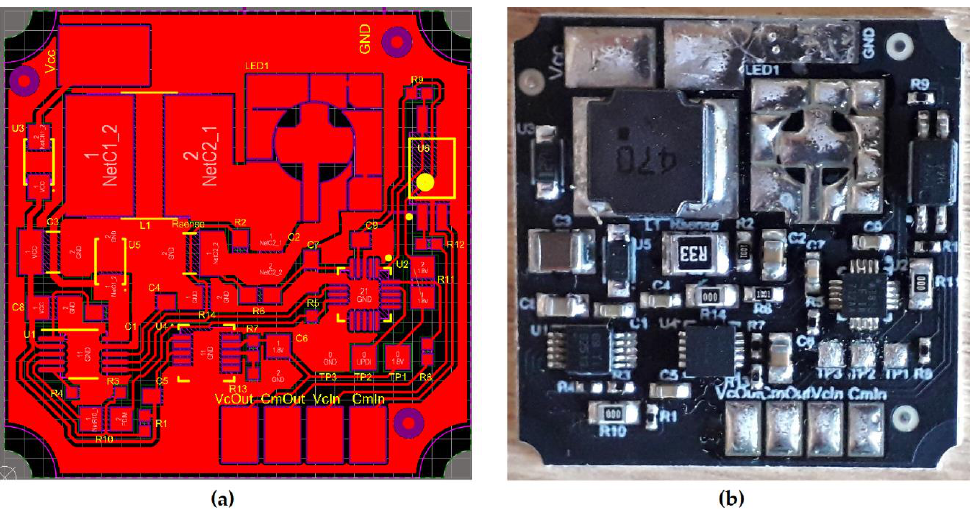
Figure 3. Schematic of the drivers’ circuit.